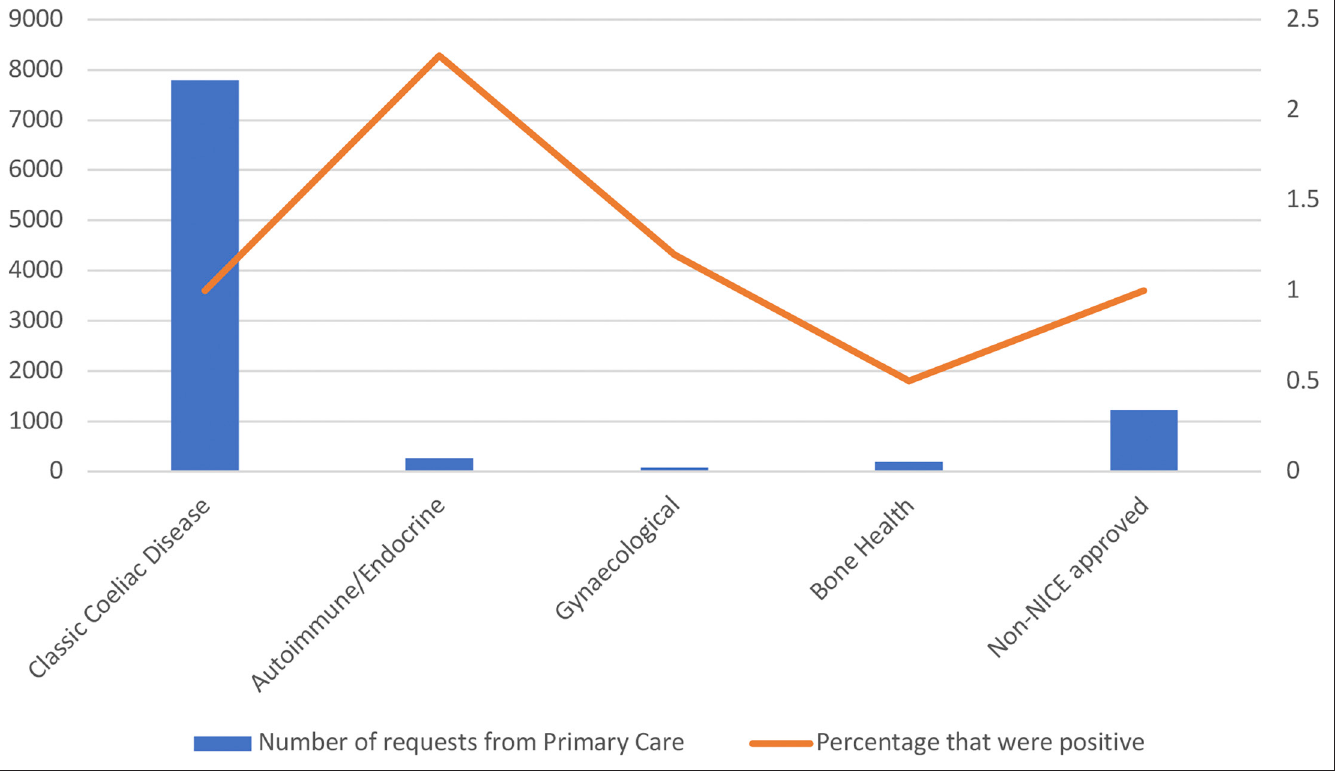
Figure 1 . Breakdown of NICE-approved requests and positive serology by indication